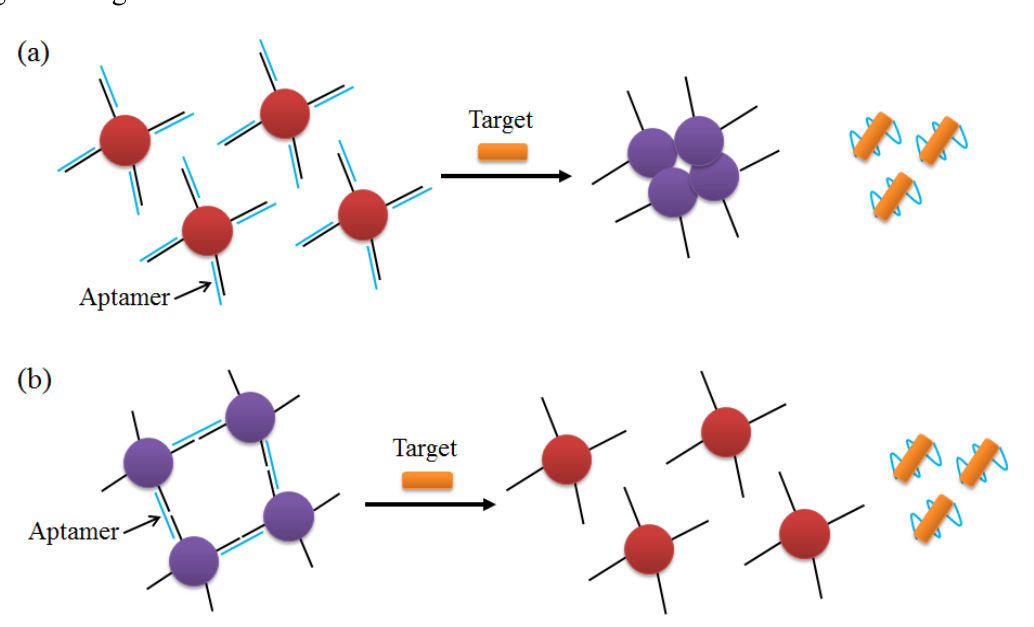
Figure 7. Schematic illustrations of optical aptasensors using AuNPs. ( a ) Aptamer release and AuNP aggregation by target binding; ( b ) Aptamer release and AuNP disaggregation by target